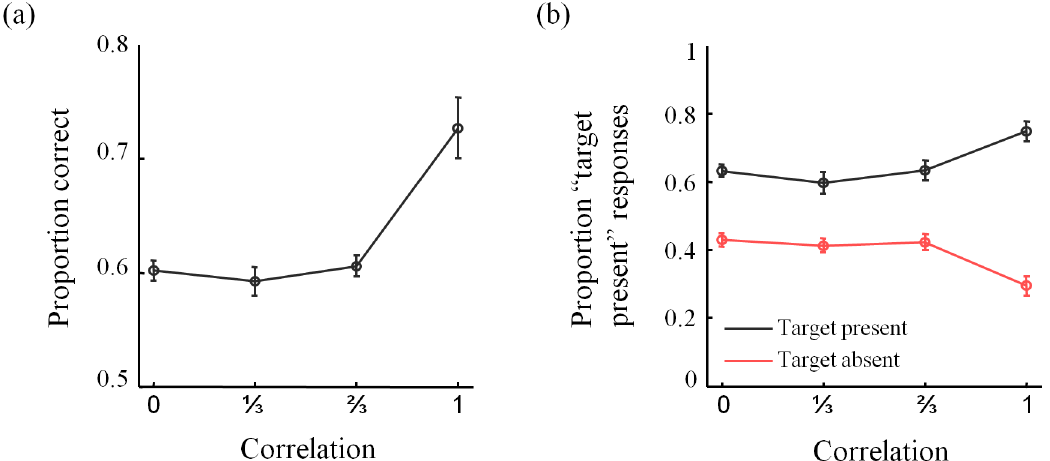
Fig 2. Psychometric curves 1. (a) Proportion correct responses and (b) hit and false alarm rates as a function of distractor correlation. Throughout the paper, error bars indicate one standard error of the mean